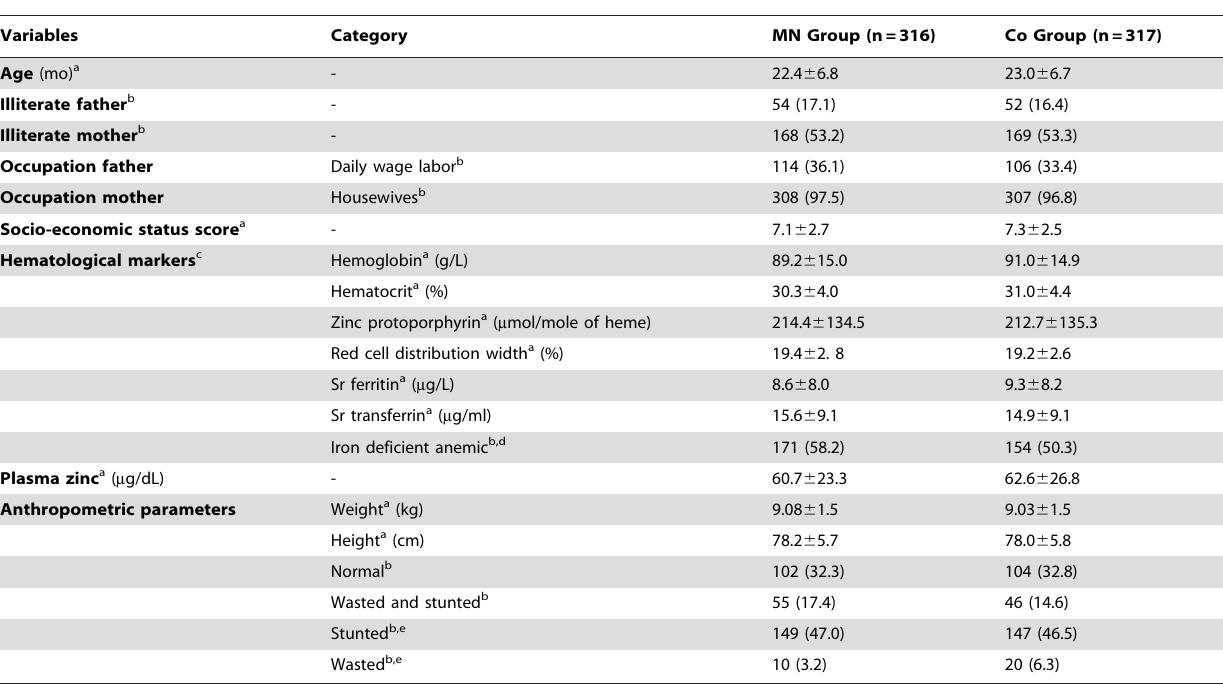
Table 2. Baseline characteristics of children included in the